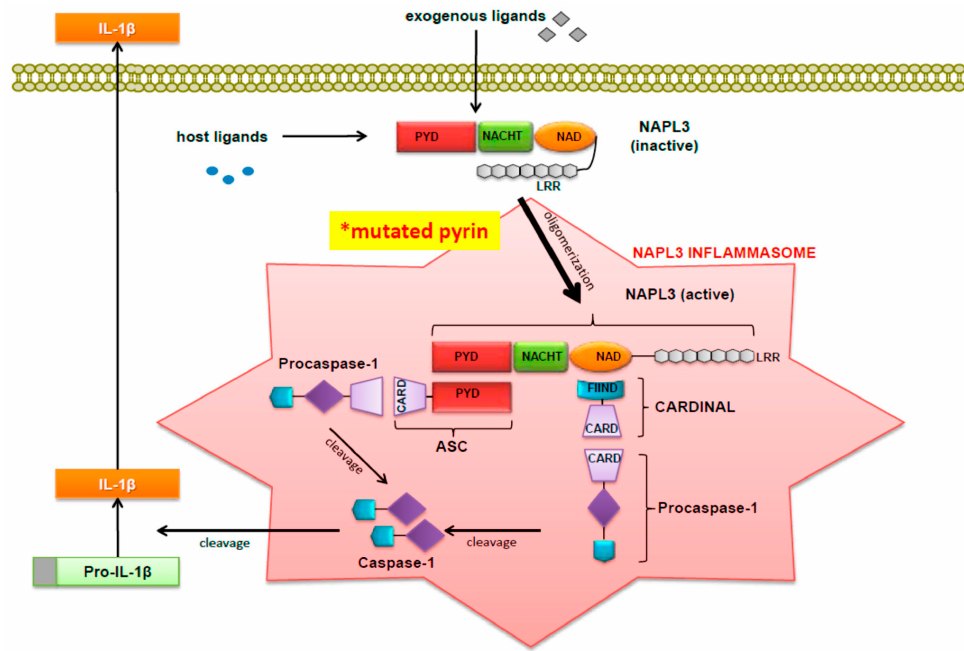
Figure 1. Activation of pro-IL-1 β by the NALP3 Inflammasome. (Figure was originally published by Wang DQH et al. and cited in this paper with permission as reference